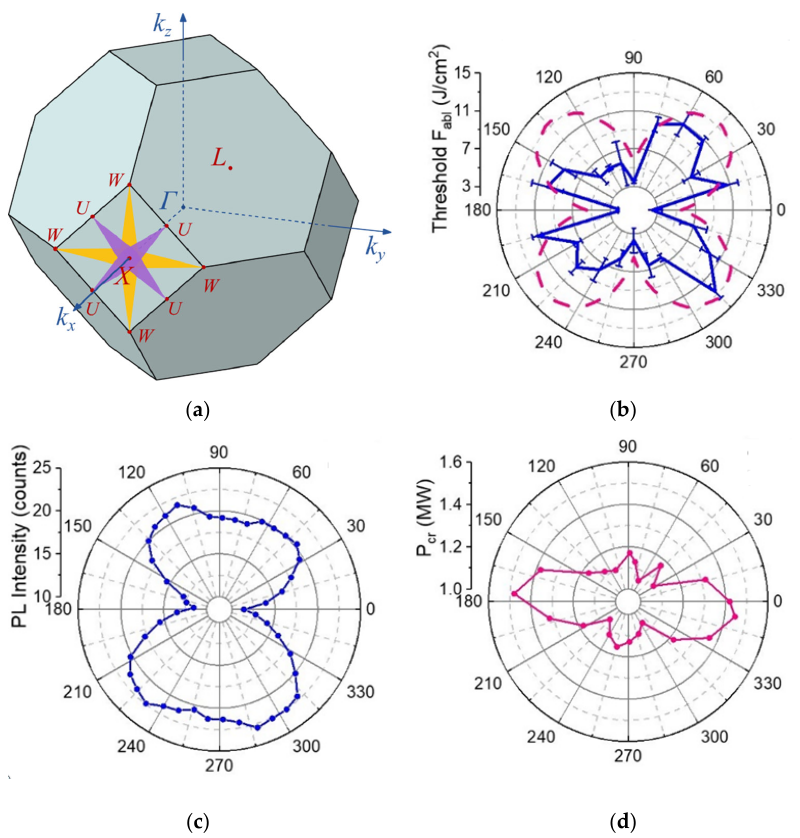
Figure 6. ( a ) Brillouin zone of a diamond and its main directions; ( b ) Polar plot of single ‐ shot 1030 nm, 300 fs ‐ laser ablation thresholds for the 100 ‐ facet diamond surface as a function of polarization angle; The pink dashed pattern denotes the direct bandgap variation in diamond; ( c ) Polar plot of bulk PL yield collected in natural diamond in the [110] direction and excited by linearly polarized 1030 nm and 300 fs ‐ laser pulses focused inside it along the 110 axis; ( d ) polar plot of the threshold energy of filamentation onset in natural diamond for linearly polarized 1030 nm and 300 fs ‐ laser pulse focused inside it along the [110] axis. Adapted from [37]. photoexcitation in cubic diamond indicate that strongly varying thresholds could be ex ‐ pected for non ‐ linear optical surface and bulk interactions in the material and its related ultrashort pulse laser patterning with the previously reported thresholds strongly differ ‐ ing for the missing control of laser polarizations and crystal orientations [96–98].